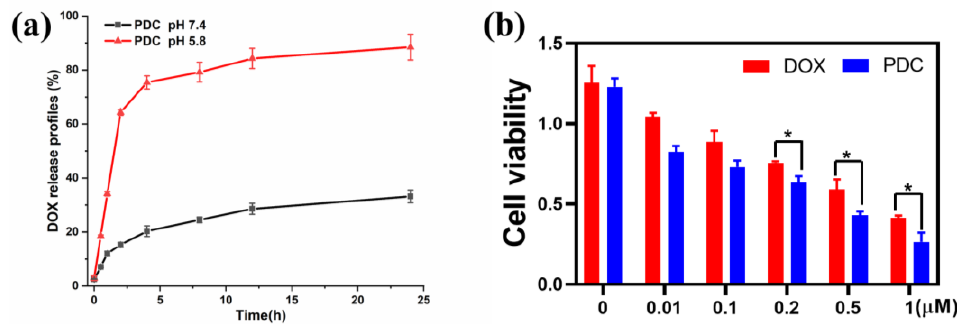
Figure 3. ( a ) In vitro release profiles of the PDC at pH 5.8 and 7.4. ( b ) Cell viability of SKBR-3 cells incubated with the PDC and free DOX for 48 h. Errors were determined with one-way analysis of variance (ANOVA). * p < 0.05 indicate statistical